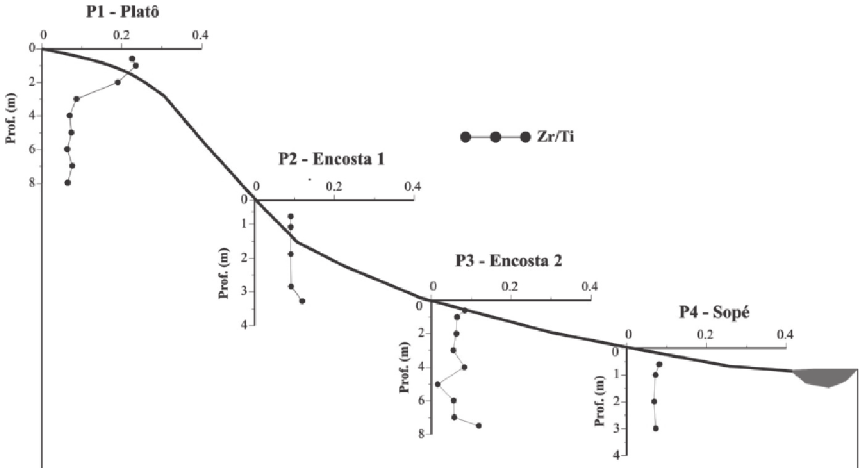
Figura 4. distribuição da relação zr/ti nos pontos estudados da